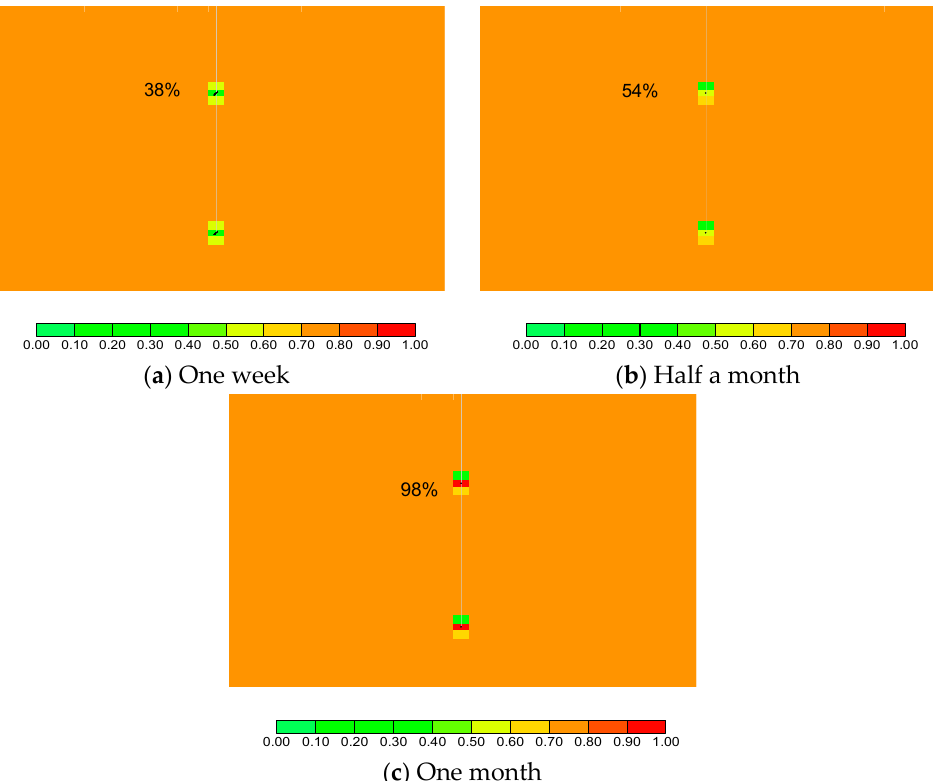
Figure 7. Oil saturation profile after electrical heating for different periods (Color bar: Oil saturation, %. ( a – c ) subfigure means electrical heating for one week, half a month, one month,